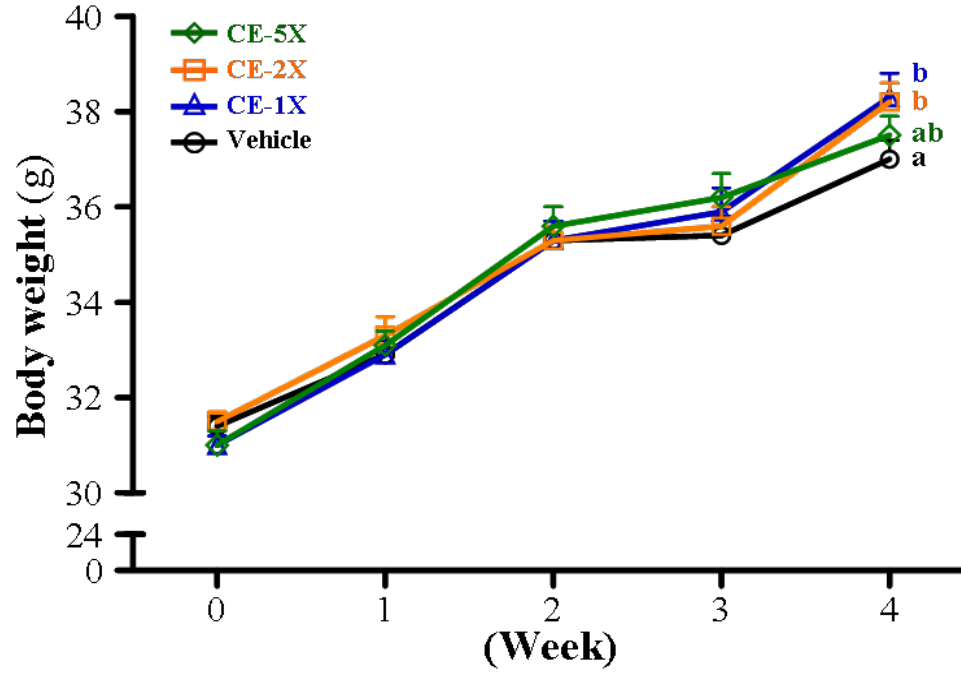
Figure 5. Effect of 4-week CE supplementation on body weight. Data are mean ± SEM for n = 10 mice per group. Different letters (a, b) indicate significant difference at p < 0.05.